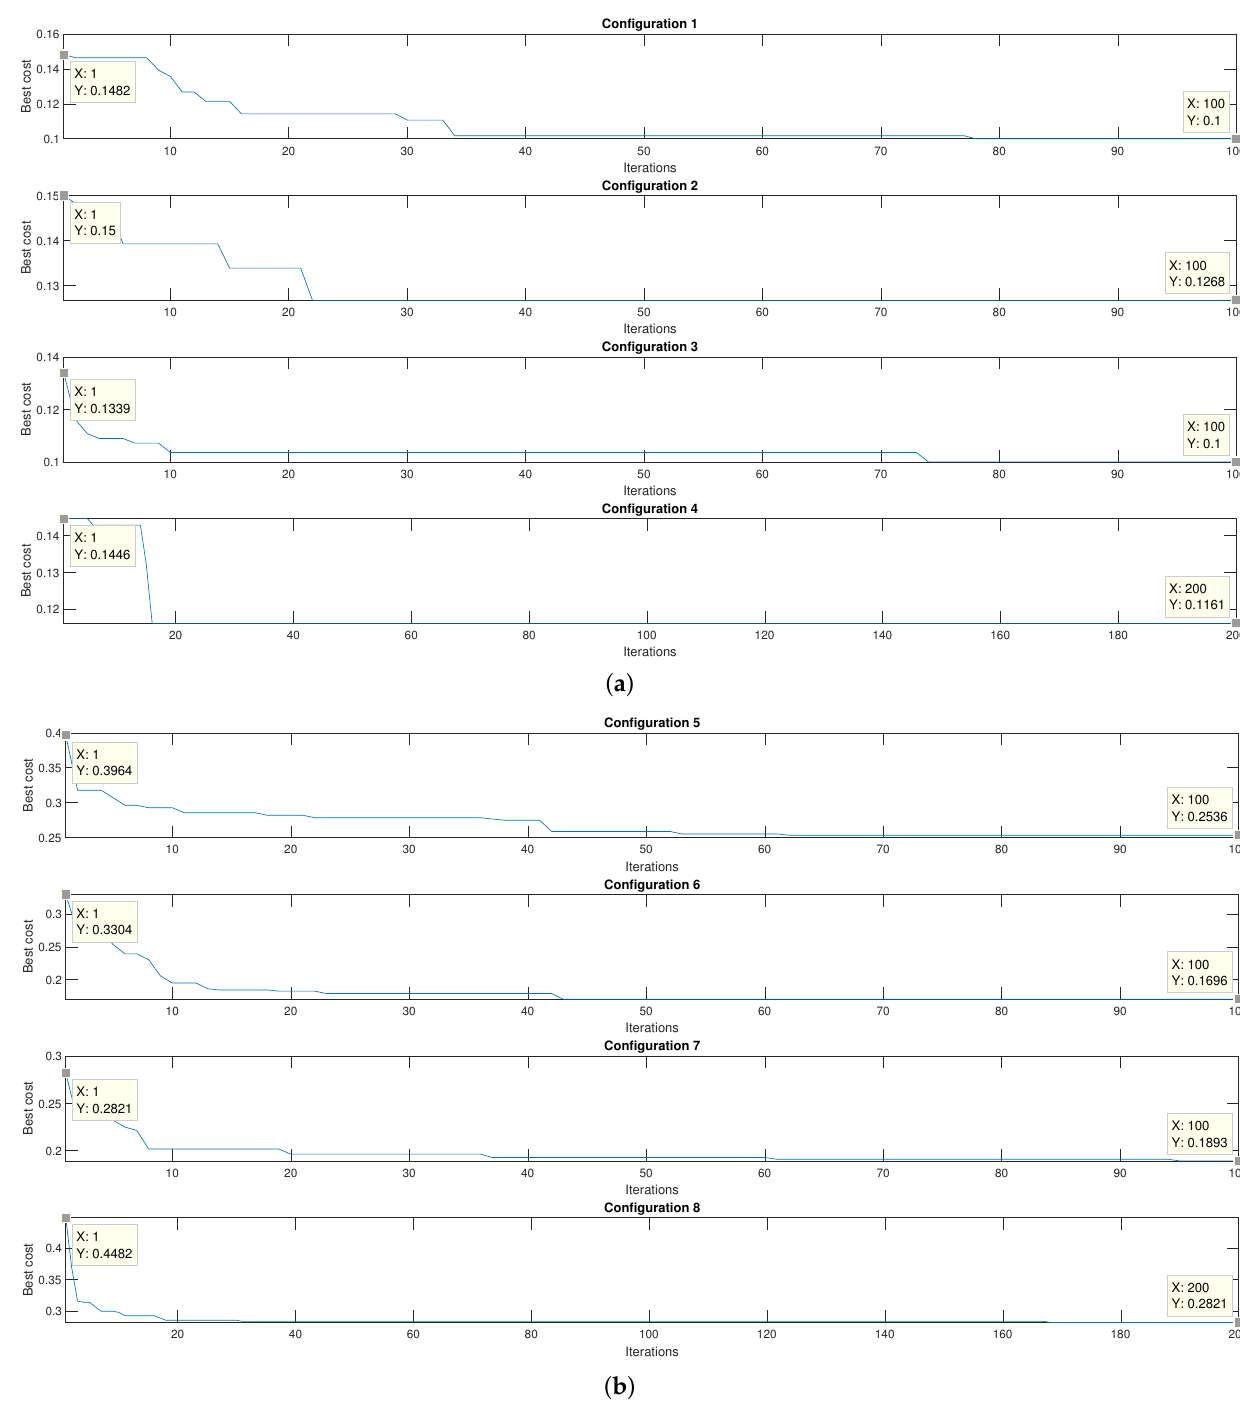
Figure 15. Plot of the classification percentage as a function of the number of iterations for ( a ) the linear kernel and ( b ) the Gaussian